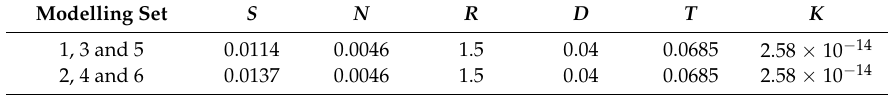
Table 9. Values of dimensionless independent factor groups (Equation (1)) in modelling Sets 1 to 6 [32]. Modelling Set